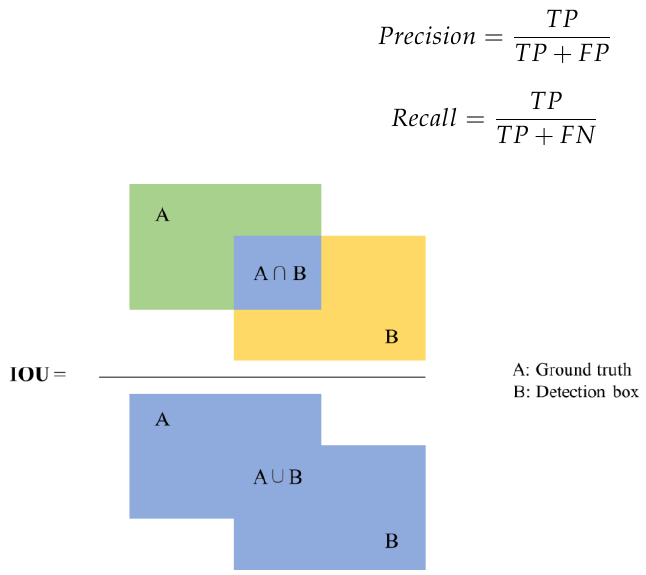
Figure 4. Calculation process of the IOU.